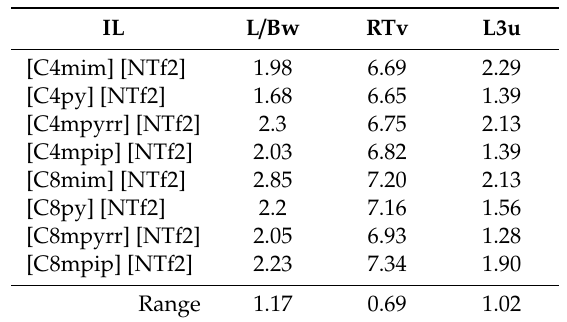
Table 4. Three-dimensional (3D) descriptors calculated for ionic pairs with the same anion present in M5